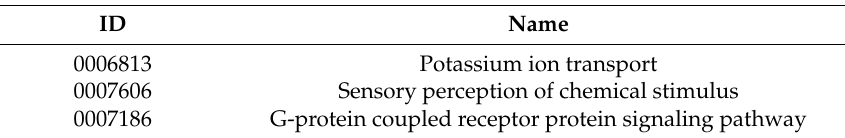
Table 4. GO Biological Processes was significantly ( p ≤ 0.05) non-redundantly downregulated in C. elegans N2 feeding with β -Cryptoxanthin (BCX) (0.025 µ g/mL) as compared with control feeding